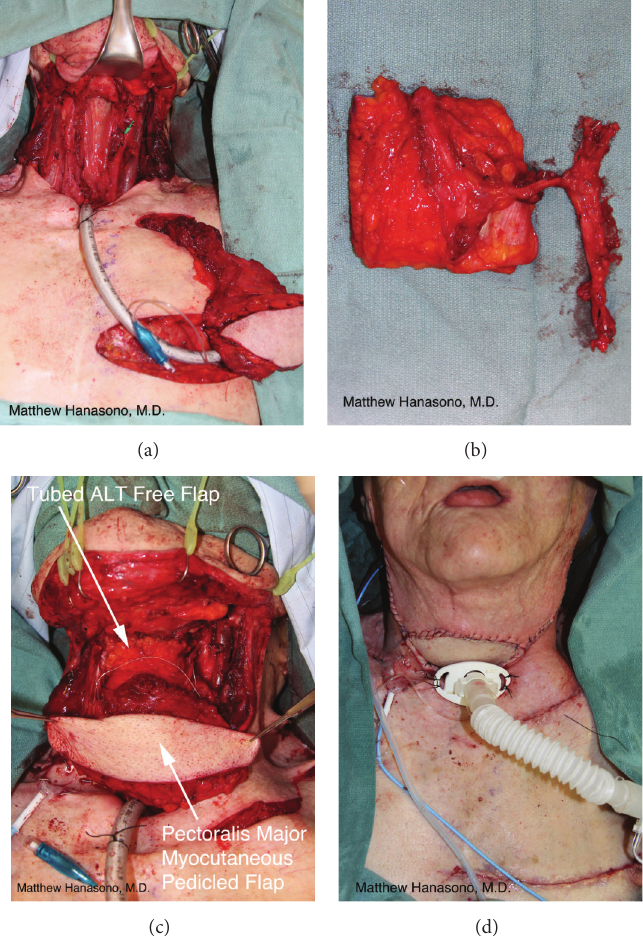
Figure 12: A total circumference pharyngeal defect following a laryngopharyngectomy for recurrent laryngeal cancer (a). A pectoralis major myocutaneous pedicled flap is dissected for neck skin coverage. The anterolateral thigh flap was dissected as a perforator flap and subsequently tubed (b). Inset of flaps (c). Postoperative appearance